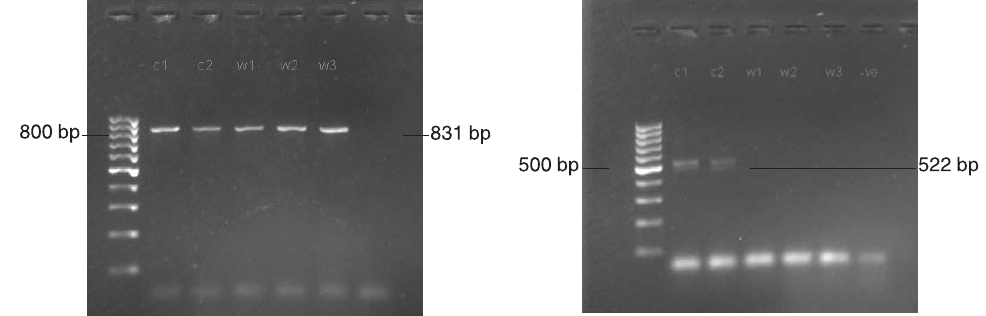
Fig. 4 . Agarose gel electrophoresis of aadA2 specific PCR Lane1: DNA marker 100bp Lane 2.3: Positive samples (522 bp) Lane 4-6: Negative samples